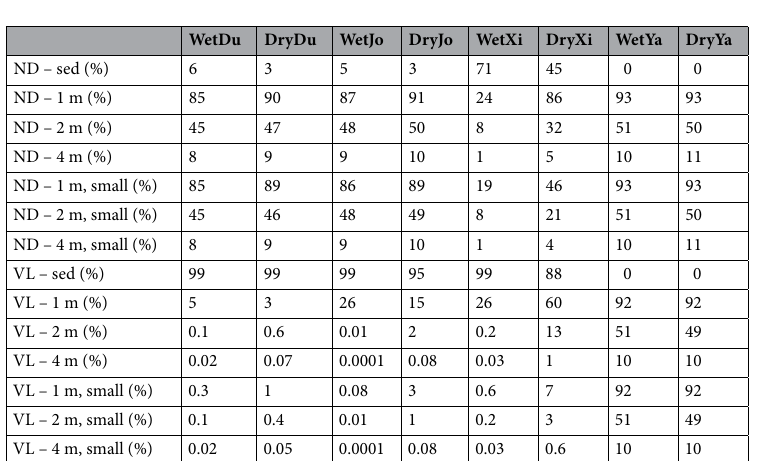
Table 1. The cumulative number of droplets (ND) and viral load (VL) measured in the numerical experiments. Note that all the values are given in percentage. Quantities denoted with ‘sed’ correspond to droplets that settle on the ground within the simulation; Quantities denoted with ‘1 m’, ‘2 m’ and ‘4 m’ correspond to airborne droplets travelling up to distances of 1, 2 and 4 m respectively; Quantities denoted with ‘small’ correspond to to droplets with diameter smaller than 10 µ